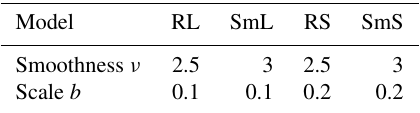
Table 2. Varying parameters in Eq. (2) for the four groups of artifi- cial ensemble